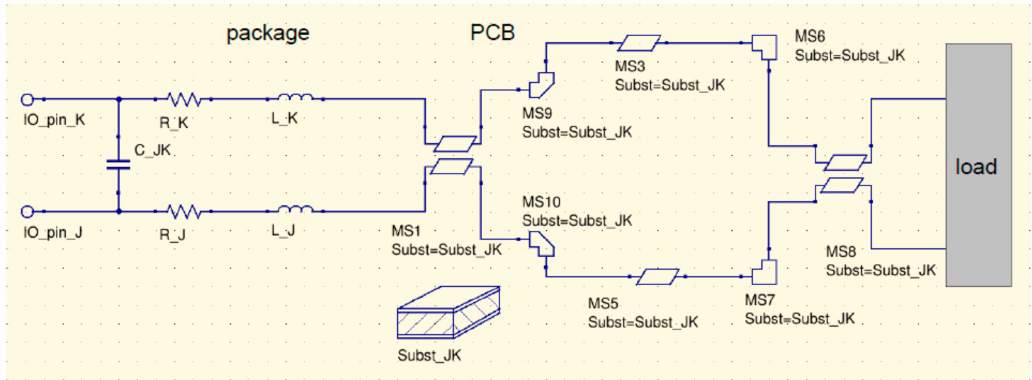
Figure 3. The proposed circuital model to describe the subparts package + PCB in Figure 1. Here the route from two generic I/O pins to the final load is shown, passing through the package and the